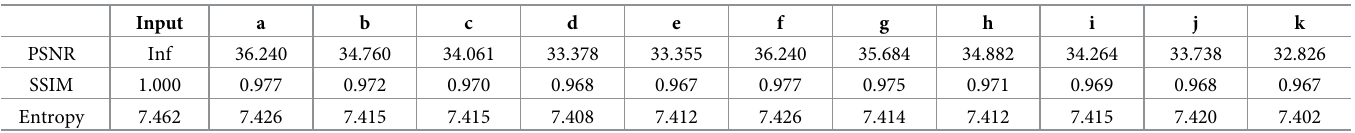
Table 1. Index values of images processed with different parameters.